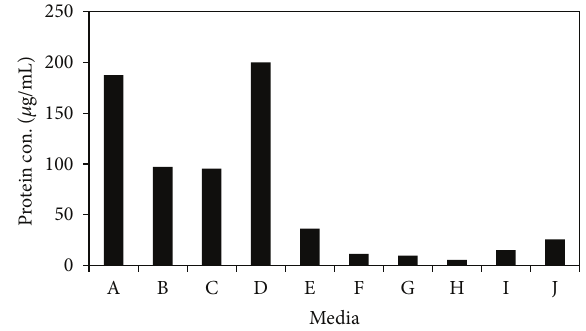
Figure 3: Histogram of protein concentration in different media— A: MGYP broth, B: PDB, C: lipase production medium, D: protease production medium, E: sucrose peptone yeast broth, F: gluten glucose medium, G: richard’s medium, H: czapek dox medium, I: glucosepeptoneyeastbroth,andJ:sabouraudbroth:Highestprotein